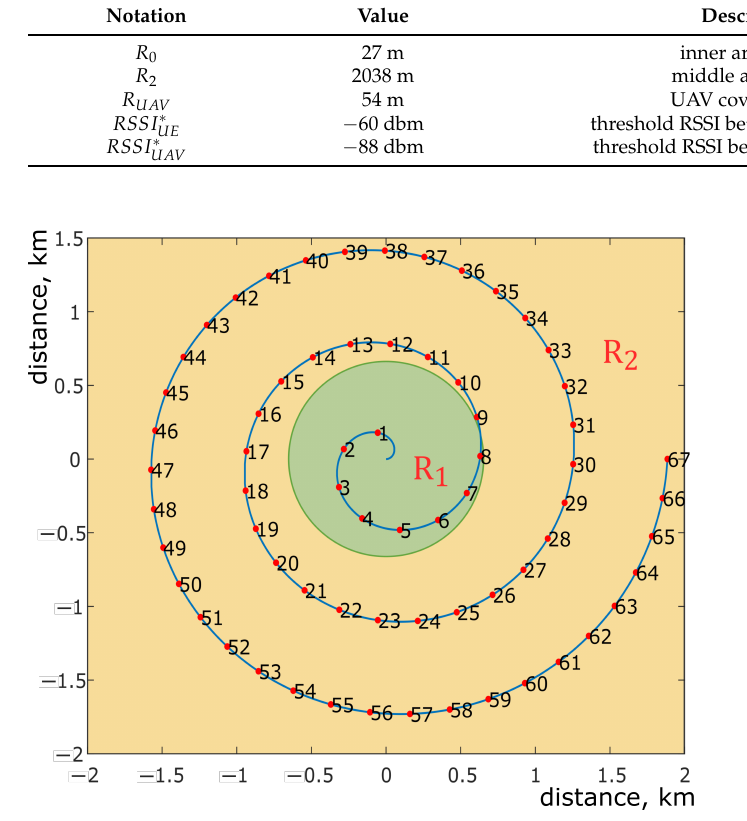
Figure 7. Testbed connection diagram depicts the movement trajectory of the UE with the blue line. The green circular area corresponds to the boundary between the BS coverage area, where the UE can be served by the BS directly and the middle area, where the UE should be served via the UAV. The red dots depict the measurement points at which system characteristics, such as packet loss and throughput on the UE side, were